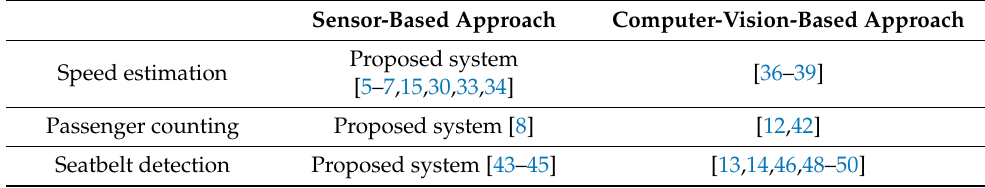
Table 1. Classification of related studies based on the objectives and technologies.